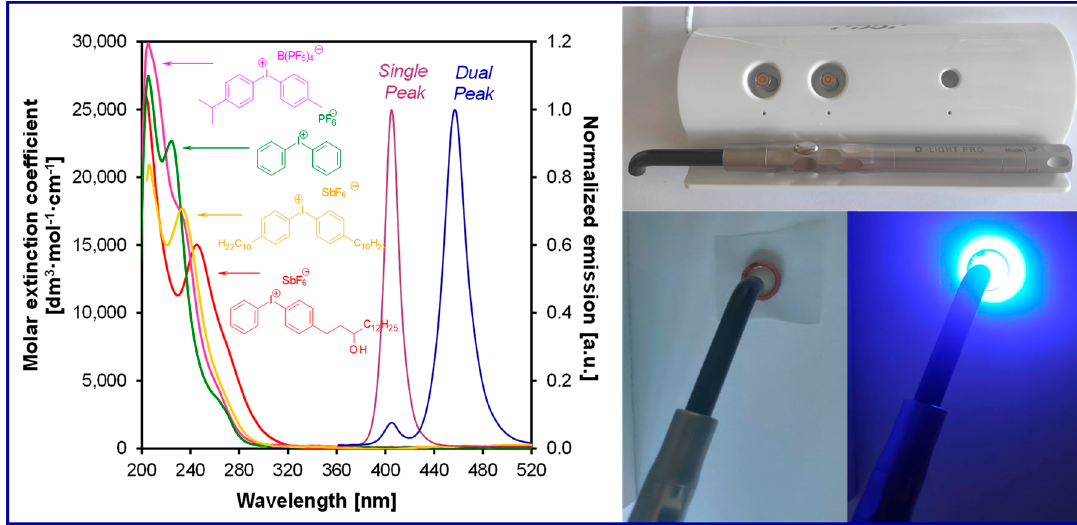
Figure 22. Comparison of the absorption characteristics of commercial iodonium photoinitiators with the emission characteristics of a commercially available dental lamp D -LIGHT ® PR and photograph of the lamp.